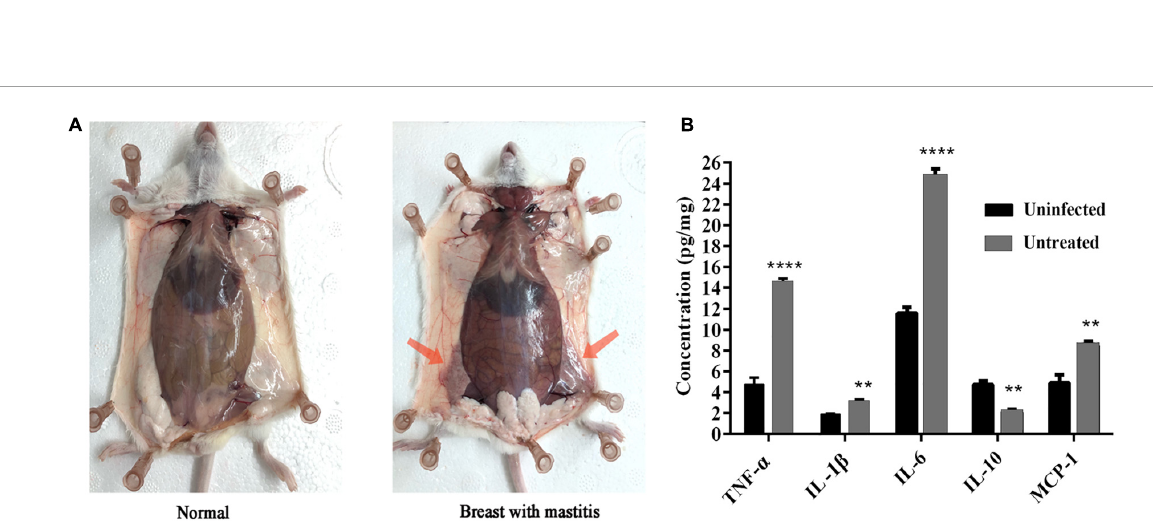
FIGURE4 Establishment of murine mastitis model. (A) Pathological changes of mammary glands in mouse. (B) The change of inflammatory cytokine. A probability value of < 0.05 was considered significant. (*) Indicates the significance between uninfected and untreated groups. ** p < 0.01; **** p < 0.0001. The results are given as the means ± SDs ( n =